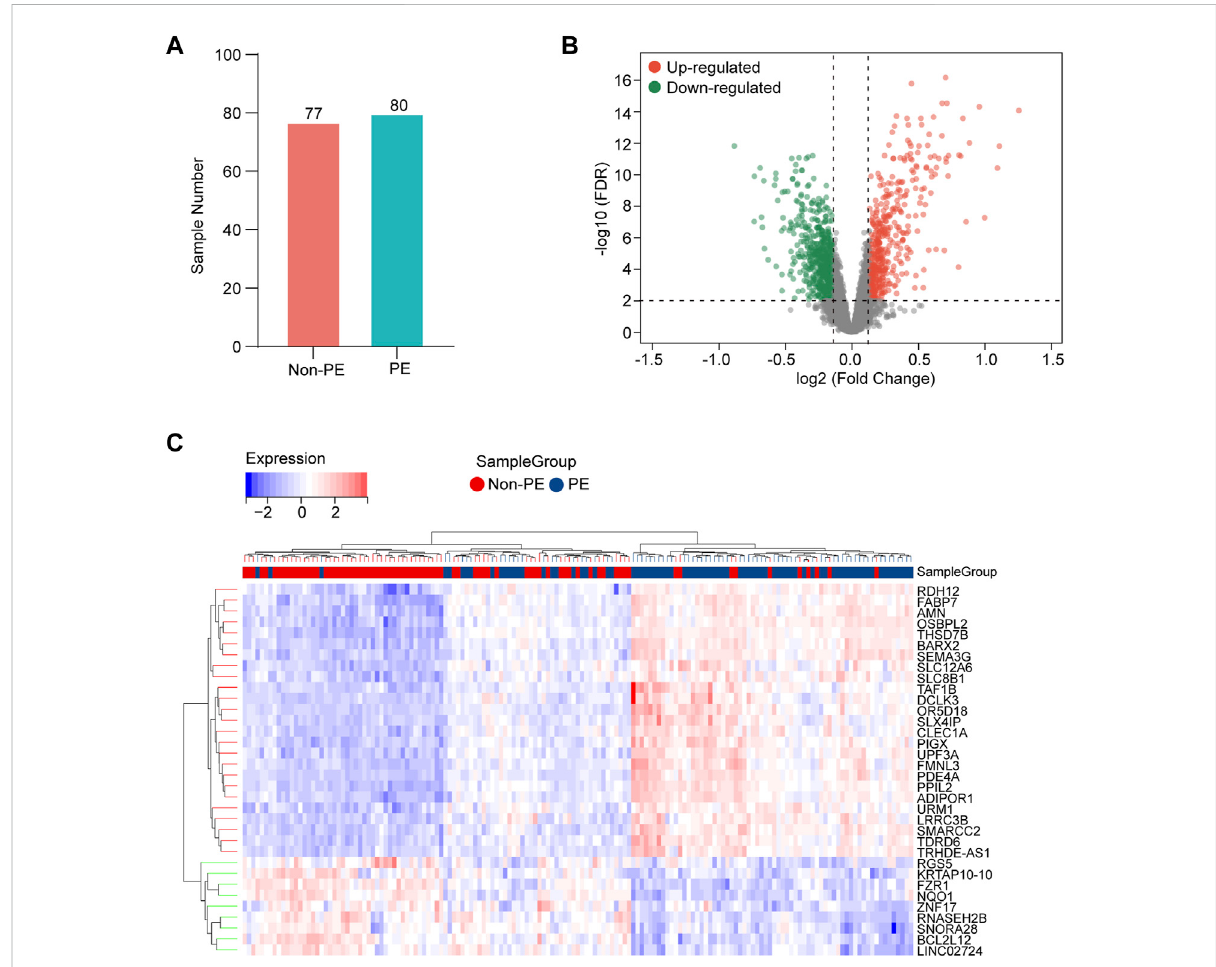
FIGURE 2 Identi fi cation of DEGs in the placenta samples. (A) Information of sample sizes. (B) Volcano plot. Red dots represent upregulated genes, gray dots represent non-signi fi cant genes, and green dots represent downregulated genes. (C) Heatmap for hierarchical clustering of DEGs in non-PE group and PE